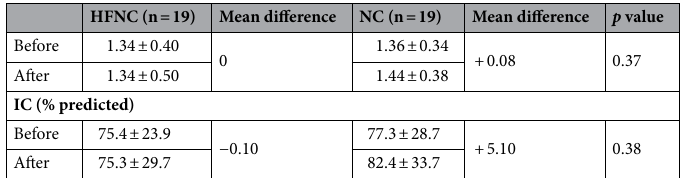
Table 3. The effect of HFNC and NC intervention on respiratory impedance evaluated by PFT. Analysis of Covariance (ANCOVA) test, p < 0.05. HFNC high flow nasal cannula, NC nasal cannula, FEV1 forced expiratory volume that has been exhaled at the end of the first second of forced expiration, FVC forced vital capacity, FEV3 forced expiratory volume that has been exhaled at the end of the third second of forced expiration, FEF 25–75% forced expiratory flow at 25–75% of the pulmonary volume, PEF peak expiratory flow, RV residual volume, TLC total lung capacity, FRC functional residual capacity, IC inspiratory capacity. *Significance between high-flow nasal cannula and nasal cannula.